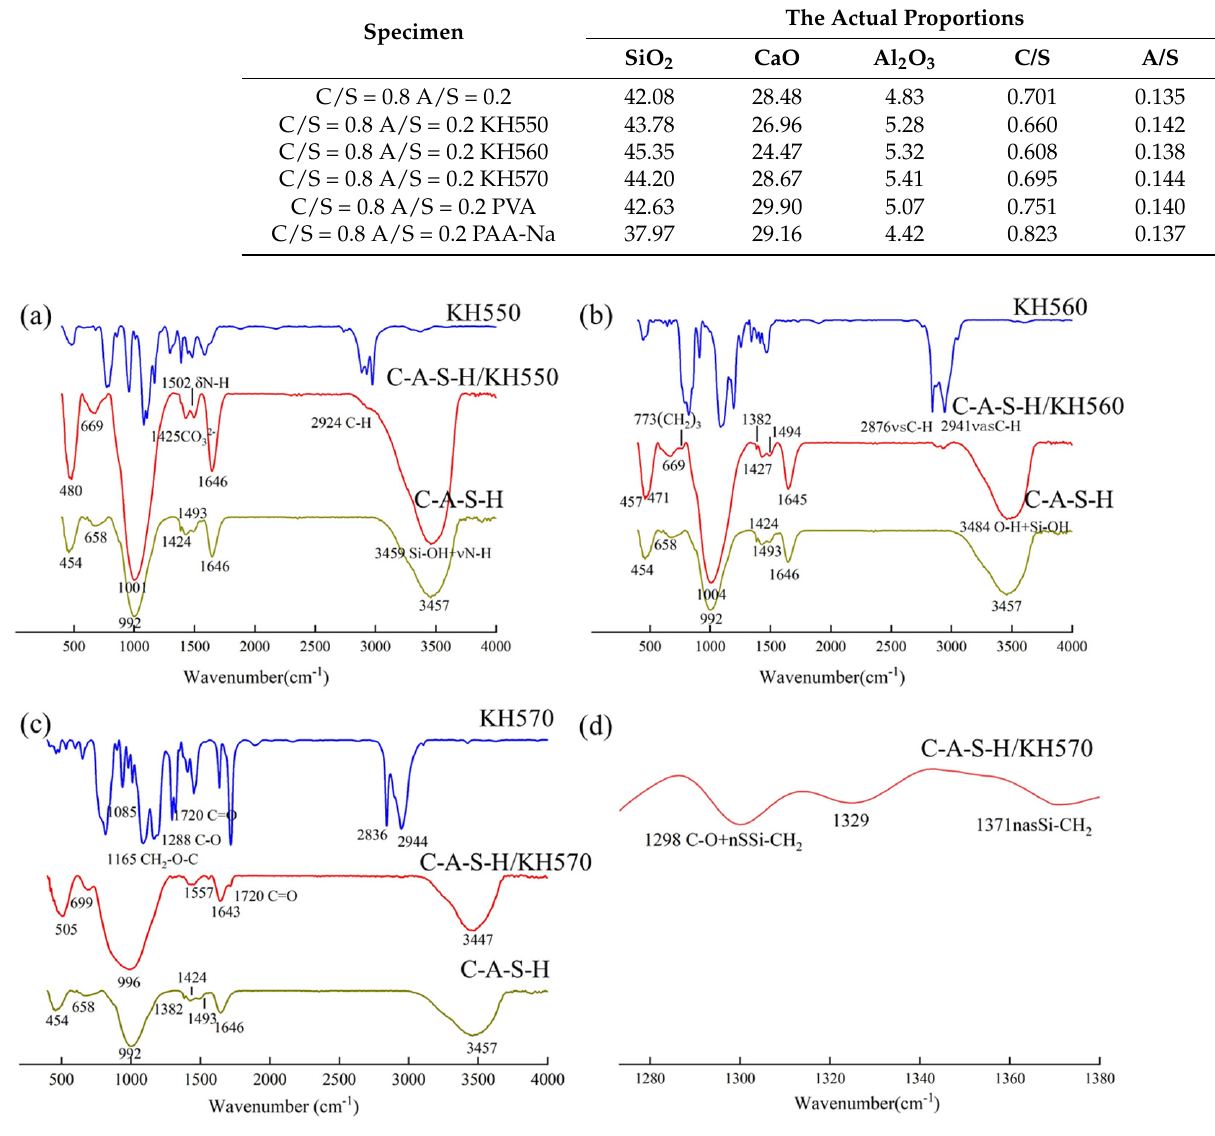
Figure 10. FTIR spectra of ( a ) C-A-S-H/KH550; ( b ) C-A-S-H/KH560; ( c ) C-A-S-H/KH570; ( d ) C-A-S-H/KH570 (Local amplification spectrum).